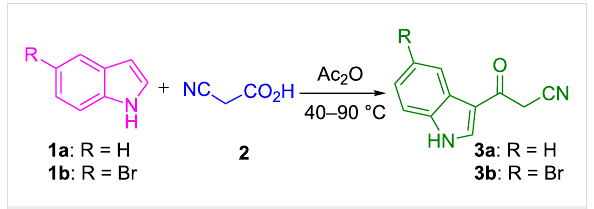
second-generation histamine H1 receptor antagonist used to treat allergic rhinitis and urticarial [30,31]. Blonanserin is an atypical antipsychotic drug used to treat schizophrenia